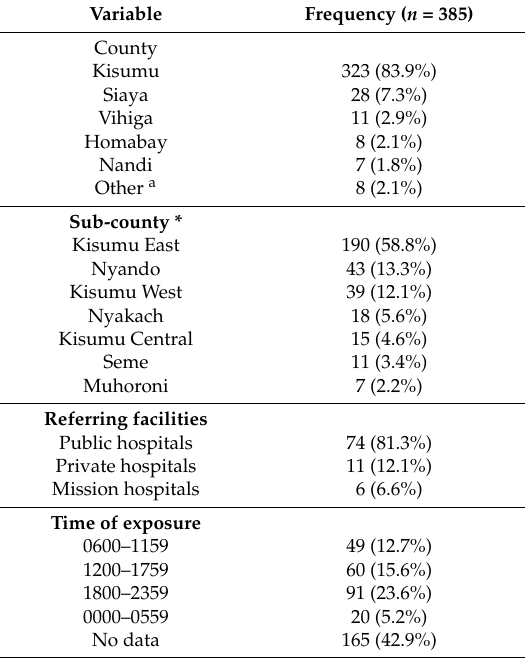
Table 2 . Location of exposure, referring facilities, exposure time, and time to hospital. Table 2. Location of exposure, referring facilities, exposure time, and time to